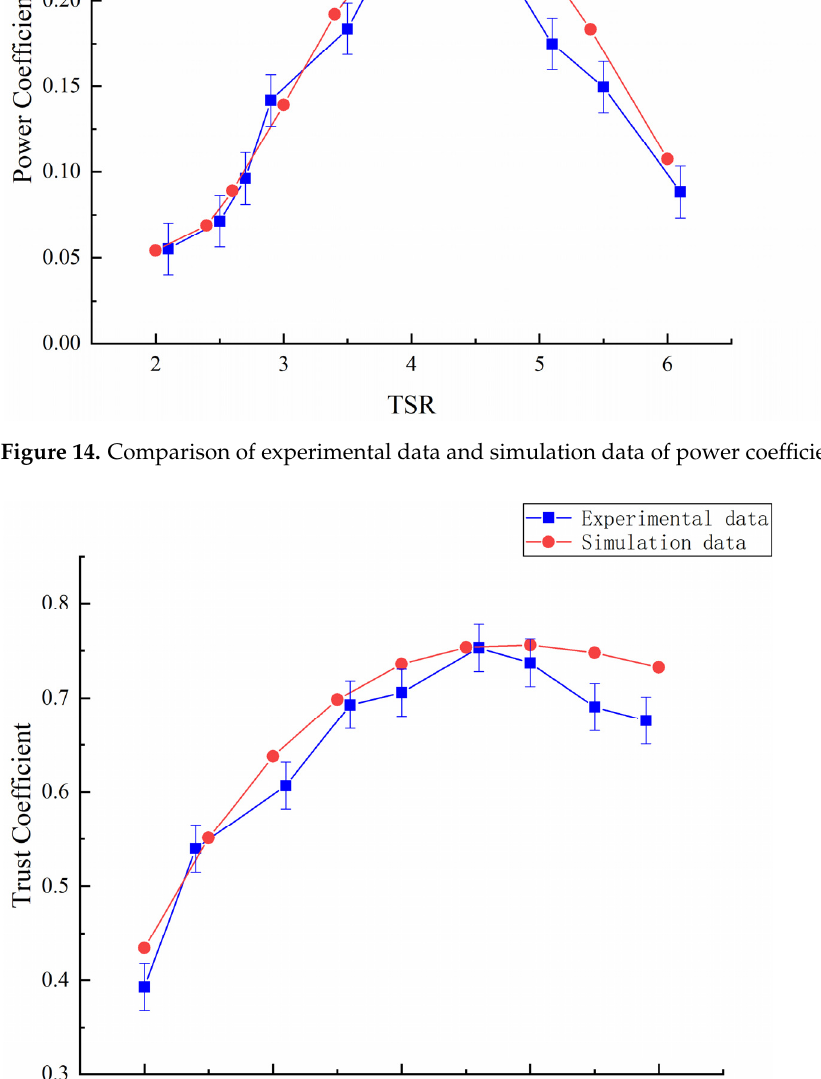
Figure 14. Comparison of experimental data and simulation data of power coefficient.